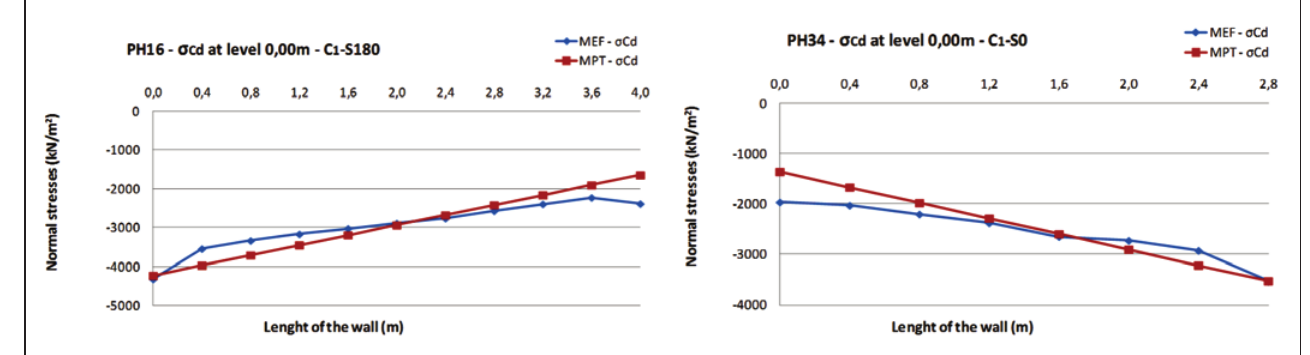
Figure 16 – Diagram of s of the walls PH16 and PH34